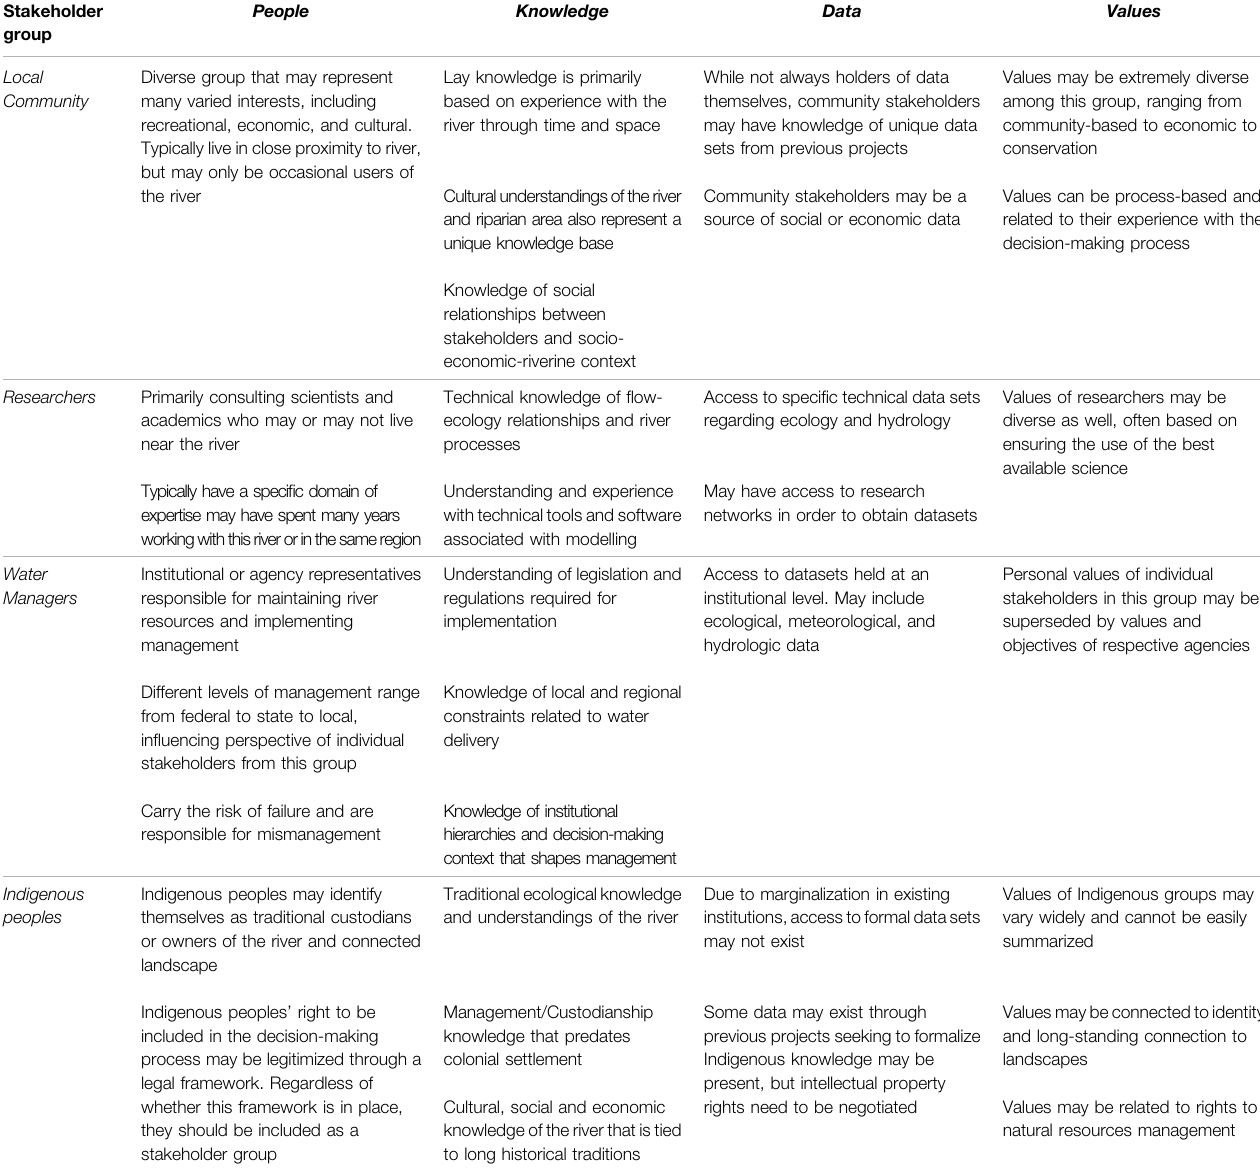
TABLE 2 | Key features of each stakeholder group based on the four elements that underpin the e- fl ows process. Stakeholder group